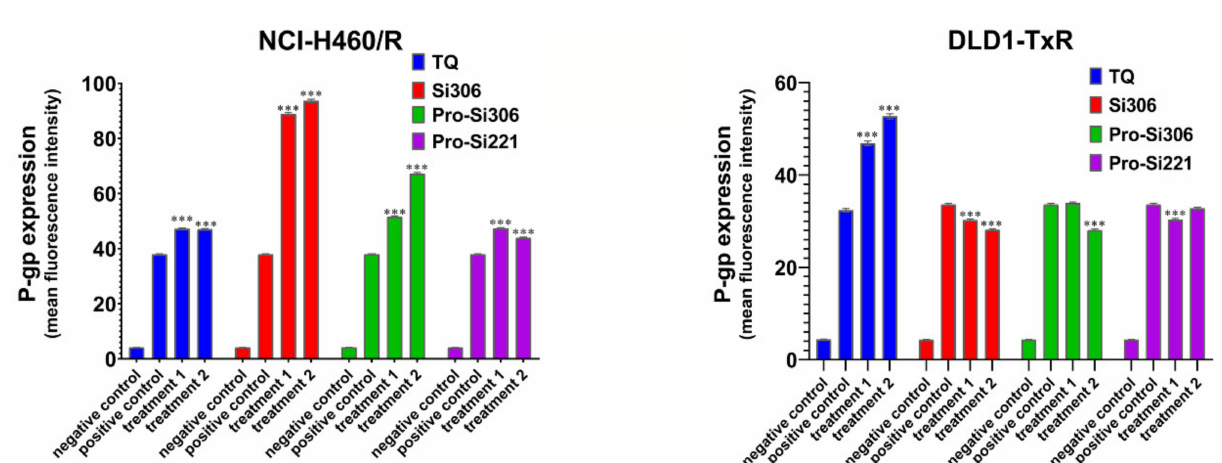
Figure 5. The effect of SFK inhibitors on P-gp expression at the protein level. Mean fluorescence intensity of primary P-gp antibody in NCI-H460/R and DLD1-TxR cells assessed after 48-h treatment with 5 µ M and 10 µ M (treatment 1 and treatment 2) for Si306 and pro-Si306 as well as 1 µ M and 2 µ M (treatment 1 and treatment 2) for pro-Si221. TQ is included as a reference compound with 5 nM for treatment 1 and 10 nM for treatment 2. The negative control is the auto-fluorescence of unstained untreated cells, whereas the positive control represents the fluorescence of anti-P-gp-labeled untreated cells. The results are expressed as the mean ± SEM. Statistically significant differences between the untreated control and treated samples calculated from three independent experiments: p < 0.001